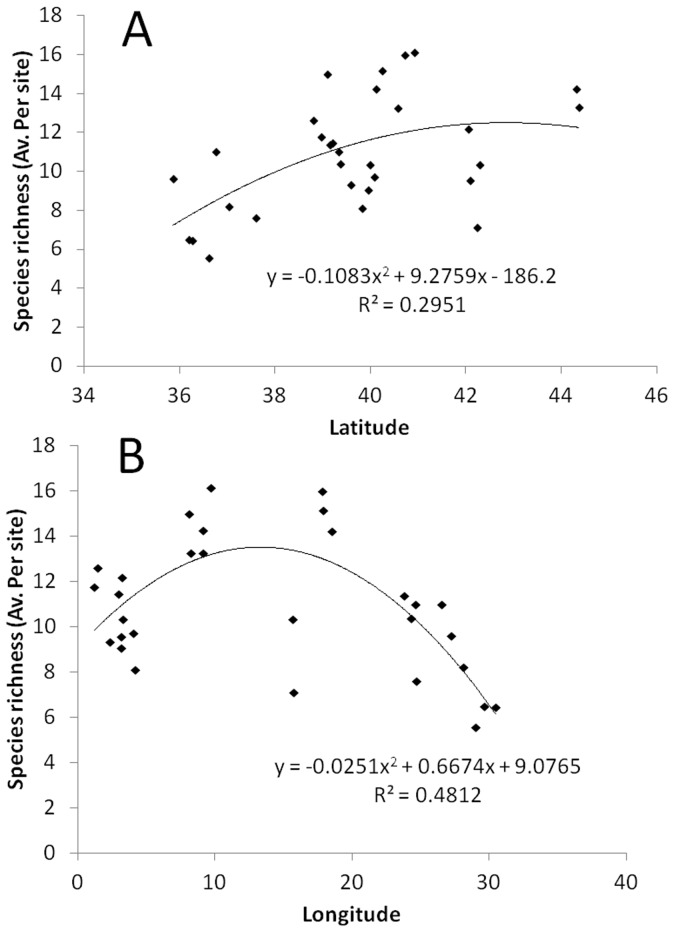
Patterns of average species richness per site versus a) latitude and b) longitude.Lines indicate 2nd order polynomial regression fitting.